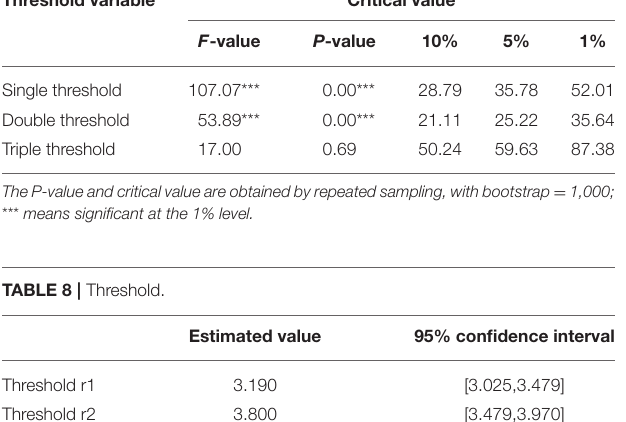
TABLE 7 | Test results for the existence of the coupling coordination degree threshold for advanced pharmaceutical manufacturing. Threshold variable